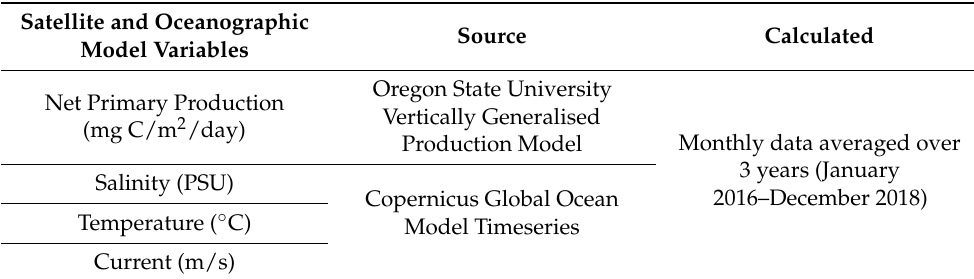
Table 2. Satellite and Oceanographic Model derived variables included in the landscape map- ping